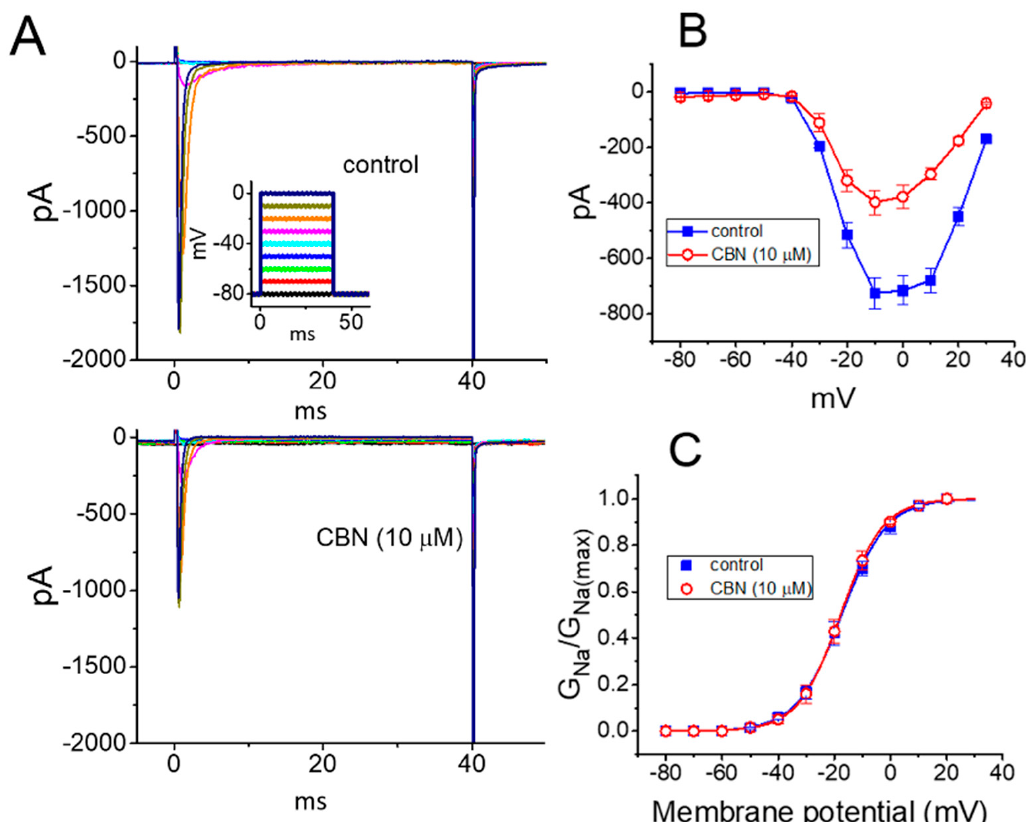
Figure 3. Effect of CBN on the current versus voltage ( I-V ) and conductance versus voltage relationship of I Na identified in GH 3 cells. ( A ) Representative current traces activated by a series of voltage commands ranging from − 80 to 0 mV in 10-mV increments. Current traces in the upper part are control, while those in the lower part were obtained in the presence of 10 µM CBN. Inset in the upper part shows the voltage-clamp profile applied. ( B ) Mean I-V relationship of peak I Na obtained in the absence ( ■ ) and presence ( ○ ) of 10 µM CBN (mean ± SEM; n = 7 for each point). Current amplitude was measured at the beginning of each voltage command. ( C ) Mean conductance versus voltage relationship of peak I Na taken in the control ( ■ ) and during the exposure ( ○ ) to 10 µM CBN (mean ± SEM; n = 7 for each point). Smooth line indicates the goodness-of-fit to the modified Boltzmann equation. Of notice, no obvious difference in conductance versus potential relationship with or without CBN addition was demonstrated.